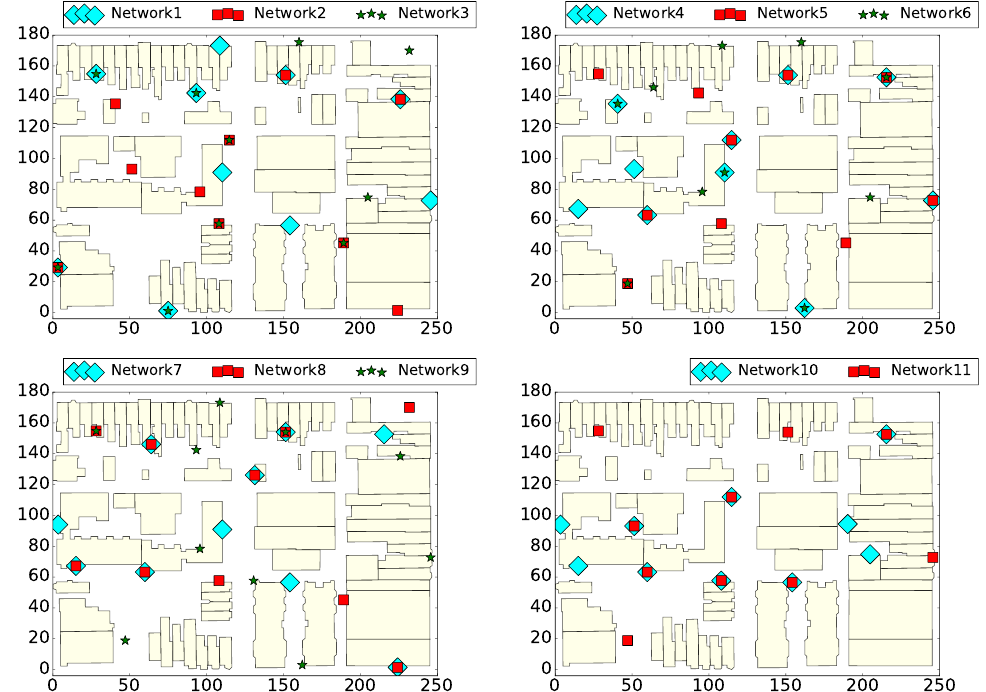
Figure 7. Random networks of sensors to be compared against the optimal network shown in the Figure